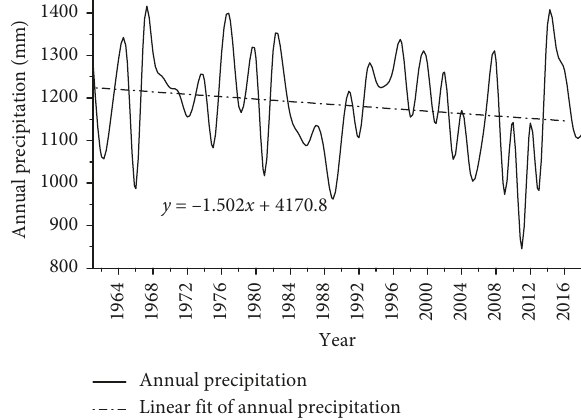
Figure 7: Evolution trends of annual precipitation from 1961 to